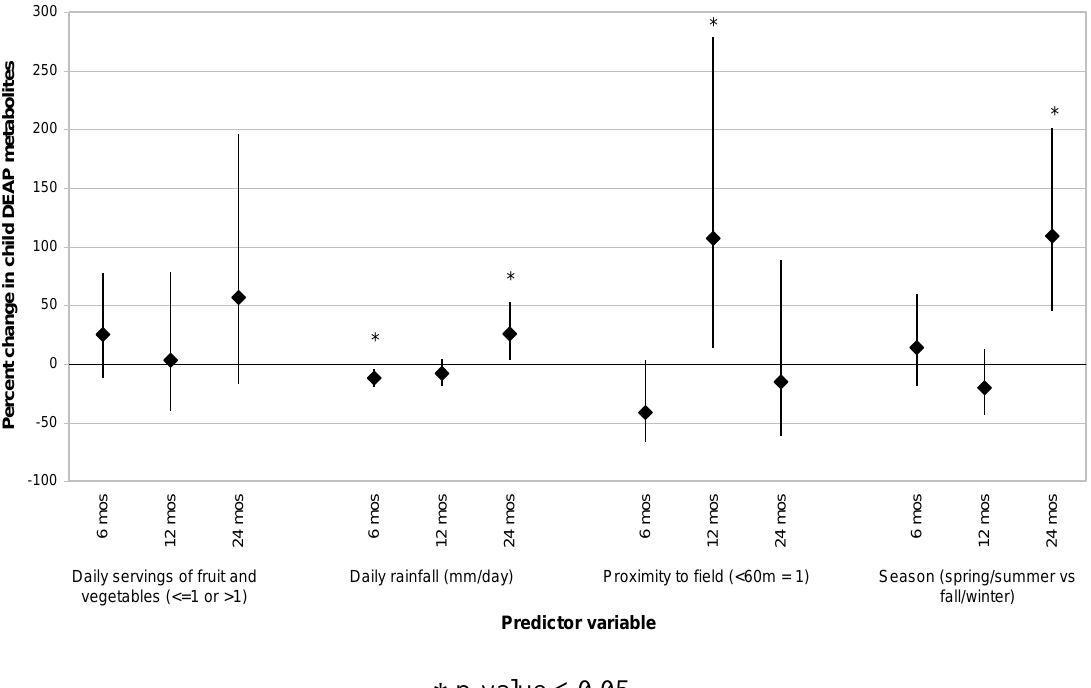
Figure S2. Percent change (and 95% CI) in DEAP metabolite per unit change or yes/no difference in predictor variable by child’s